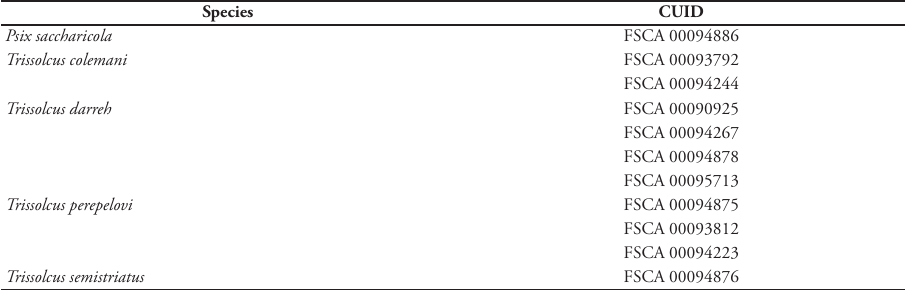
Table 2. List of specimens photographed. Full resolution images are deposited at mbd-db.osu.edu and can be retrieved via the